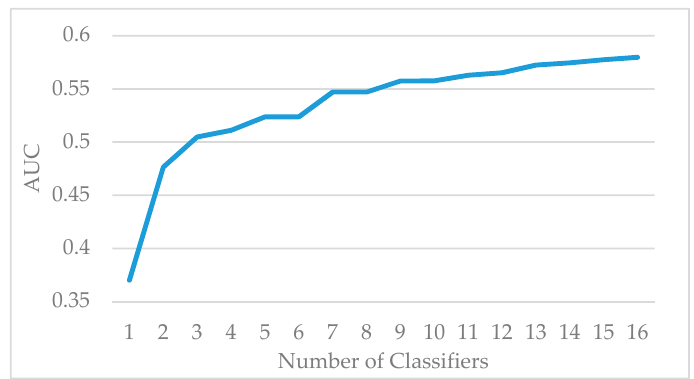
Figure 5. The AUC of AdaBoost Algorithm on KC1 Training Set.